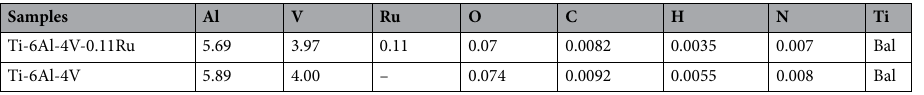
Table 4. Chemical composition of titanium alloy samples used in the tests (wt. %).